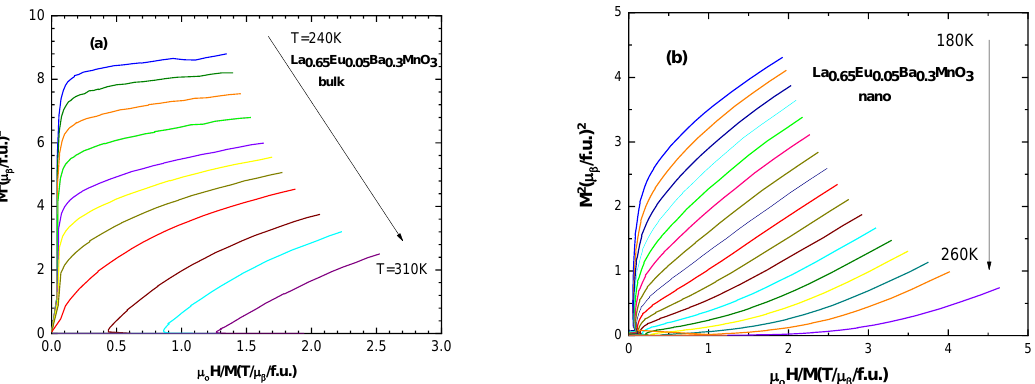
70 – 90 K for the samples with the same substitution level: T C (x = 0.1 bulk) = 270 K and T C (x = 0.1 nano) = 200 K. It is also interesting that the slope of the magnetization change of